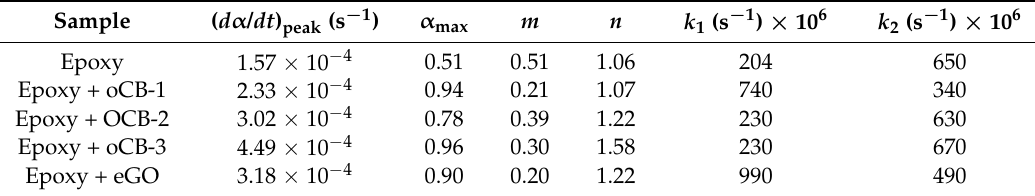
Table 5. d α / dt peak (s − 1 ) and kinetic model